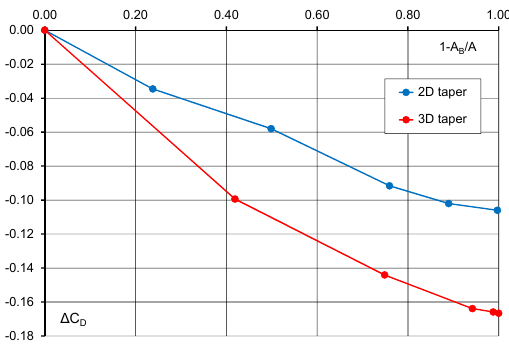
Figure 8. Drag reduction as a function of base area ratio.